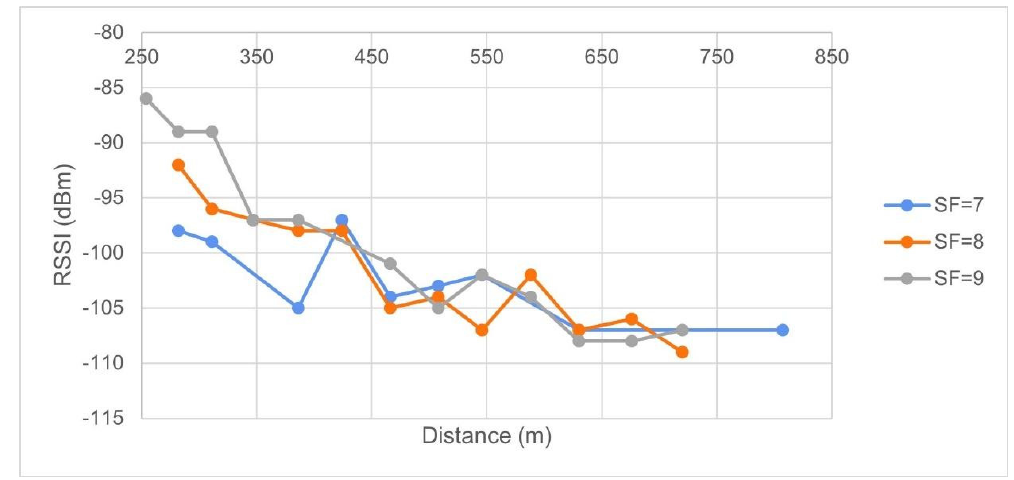
Figure 14. RSSI versus distance with BW = 125 kHz and CR = 4/7, in Experiment 4.